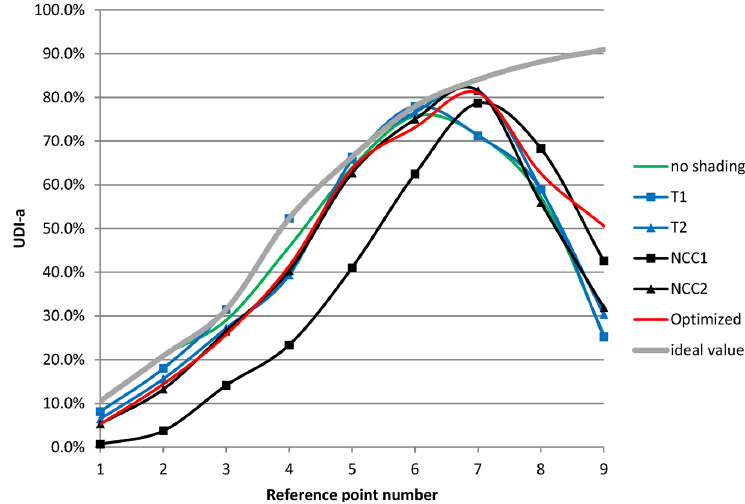
Figure 8. Profile of UDI-a for each tested